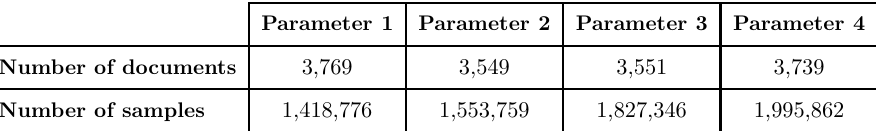
Syntactic parameters and their corpus frequency Parameter